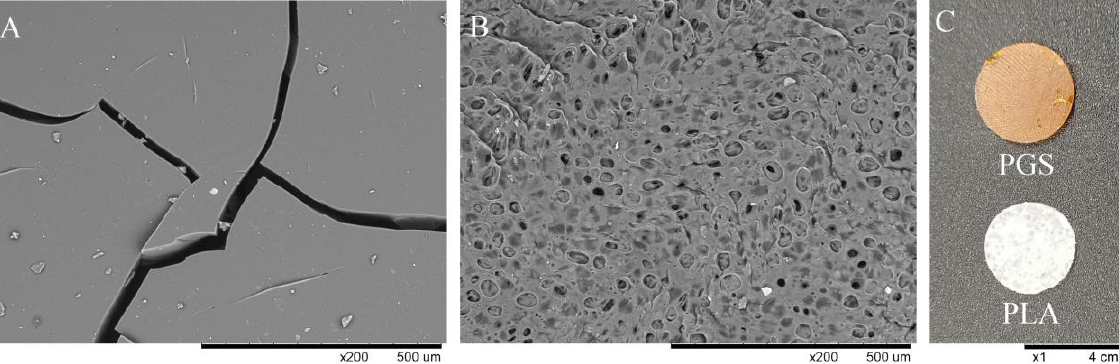
Figure 2. SEM micrographs of materials applied for scaffolds: ( A ) non-porous PGS with many deep cracks in the whole volume of the sample, ( B ) porous PLA with approx. 50 – 7 5 μm pores, and ( C ) macroscopic view of PGS and PLA scaffolds.